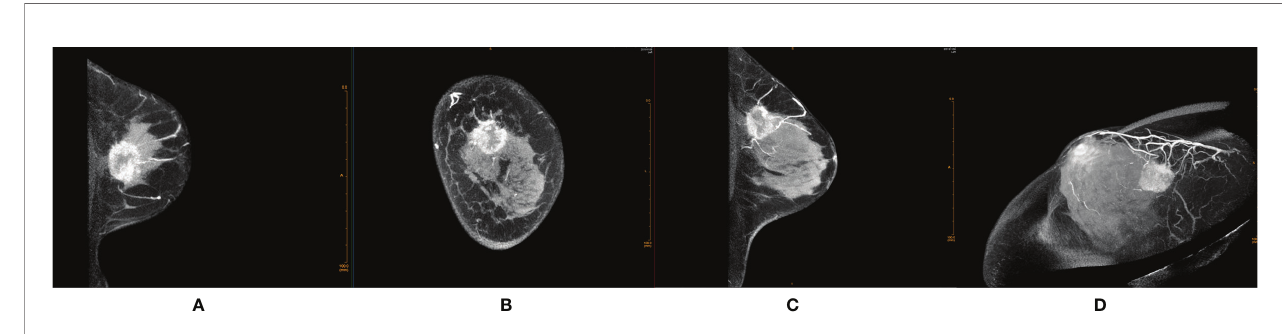
FIGURE 1 | Female, 48 years old, invasive ductal carcinoma in the left breast. (A) Transverse section. (B) Coronal section. (C) Median sagittal section. (D) MIP reconstruction images in phase 1 by CE-CBBCT. Those images showed an irregular rim-shaped enhanced mass with uneven thickness of rim paries, spicular outer margin of the rim paries, unsmooth and unde fi nite inner margin of the rim paries, and positive peripheral vascular signs (increased, thickened blood vessels around the mass and partially connected to it) in the upper quadrant of the left breast at about 12 o ’ clock. CE-CBBCT, contrast-enhanced CBBCT (CE-CBBCT); MIP, maximum intensity projection.